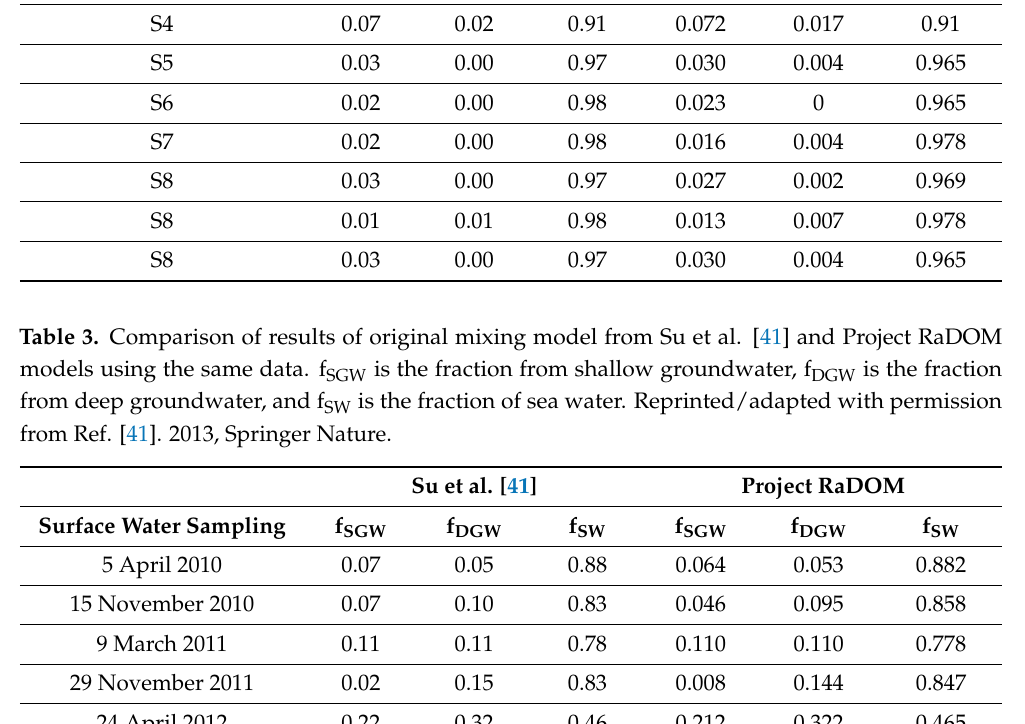
Table 2. Comparison of results of original mixing model from Moore [17] and Project RaDOM models using the same data. f ns is the fraction from nearshore groundwater, f os is the fraction from offshore groundwater, and f o is the fraction of ocean water. Reprinted/adapted with permission from Ref. [17]. 2003, Springer Nature. Moore [17] Project RaDOM Eastern Transect Station f ns